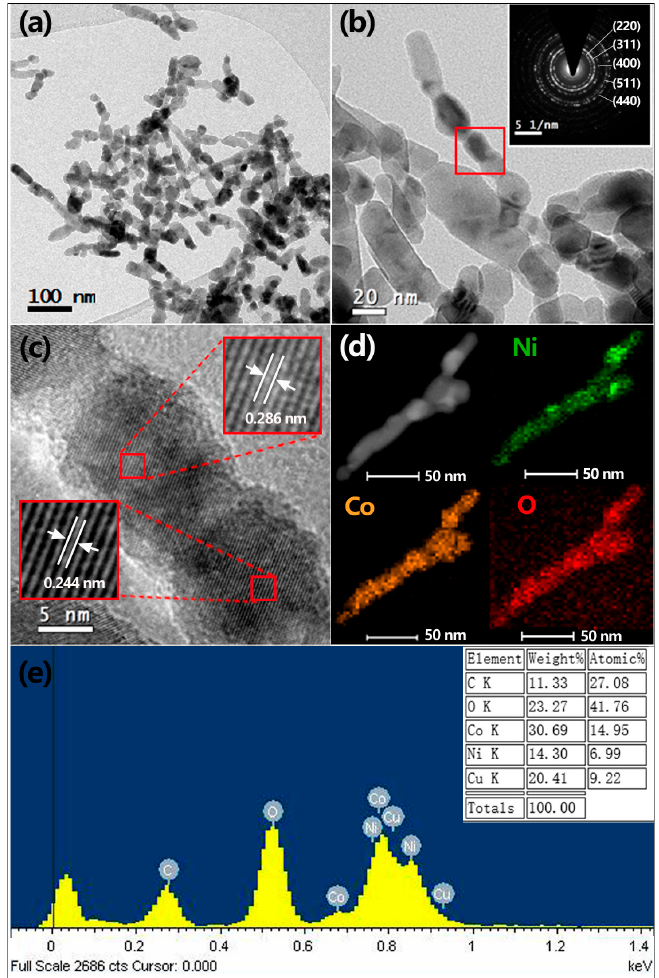
Figure 4. ( a ) Low-magnification transmission electron microscopy (TEM) image; ( b ) high-magnification TEM image, ( c ) high-resolution TEM (HRTEM) image of enlarged part marked by red square in ( b ), ( d ) elemental mapping, and ( e ) energy dispersive spectrometer (EDS) spectrum of single NiCo 2 O 4 nanowire.